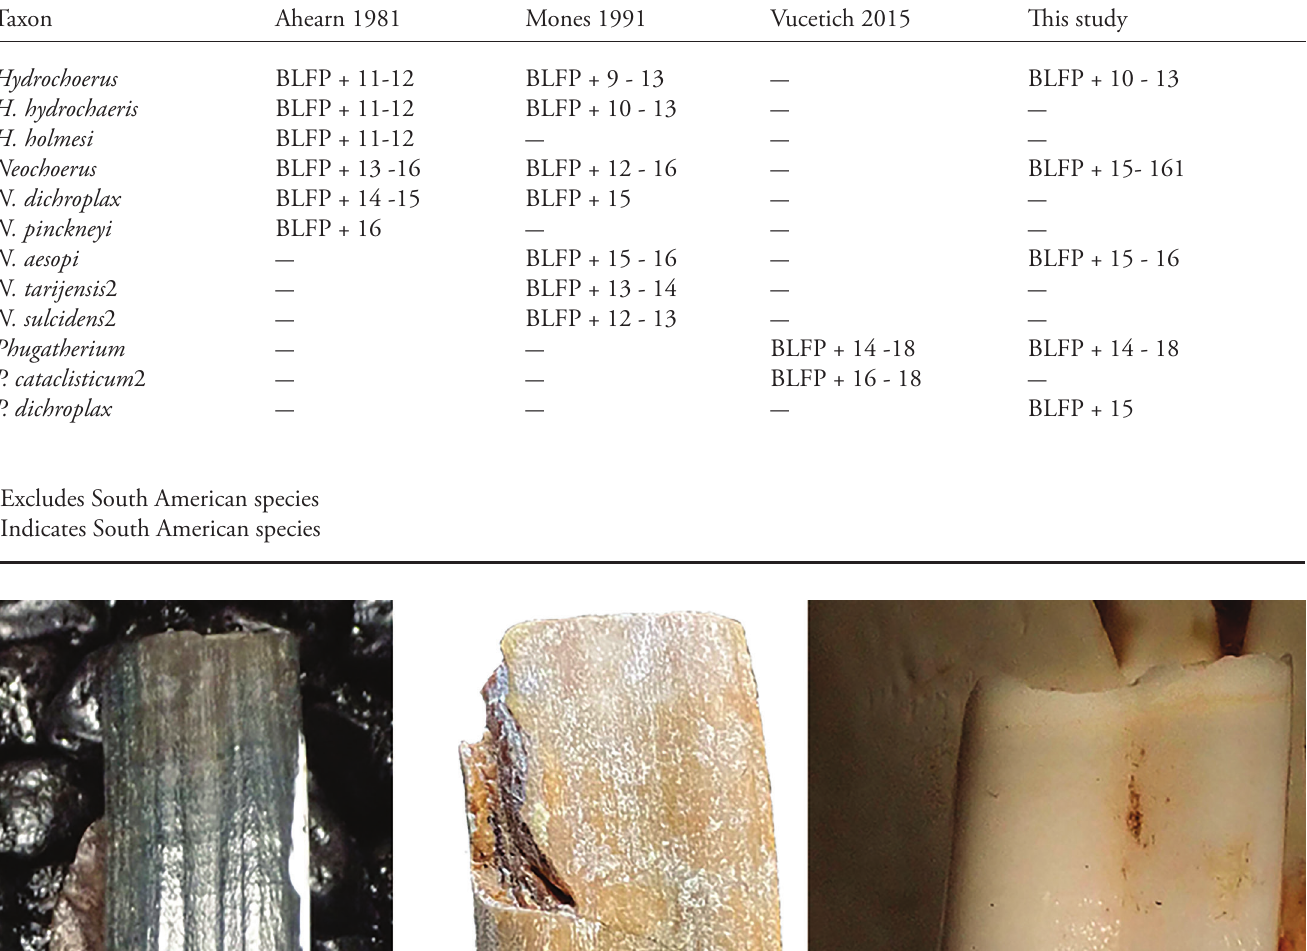
Table 4. Description of M3 in hydrochoerines by previous authors and as used in this study. Taxon